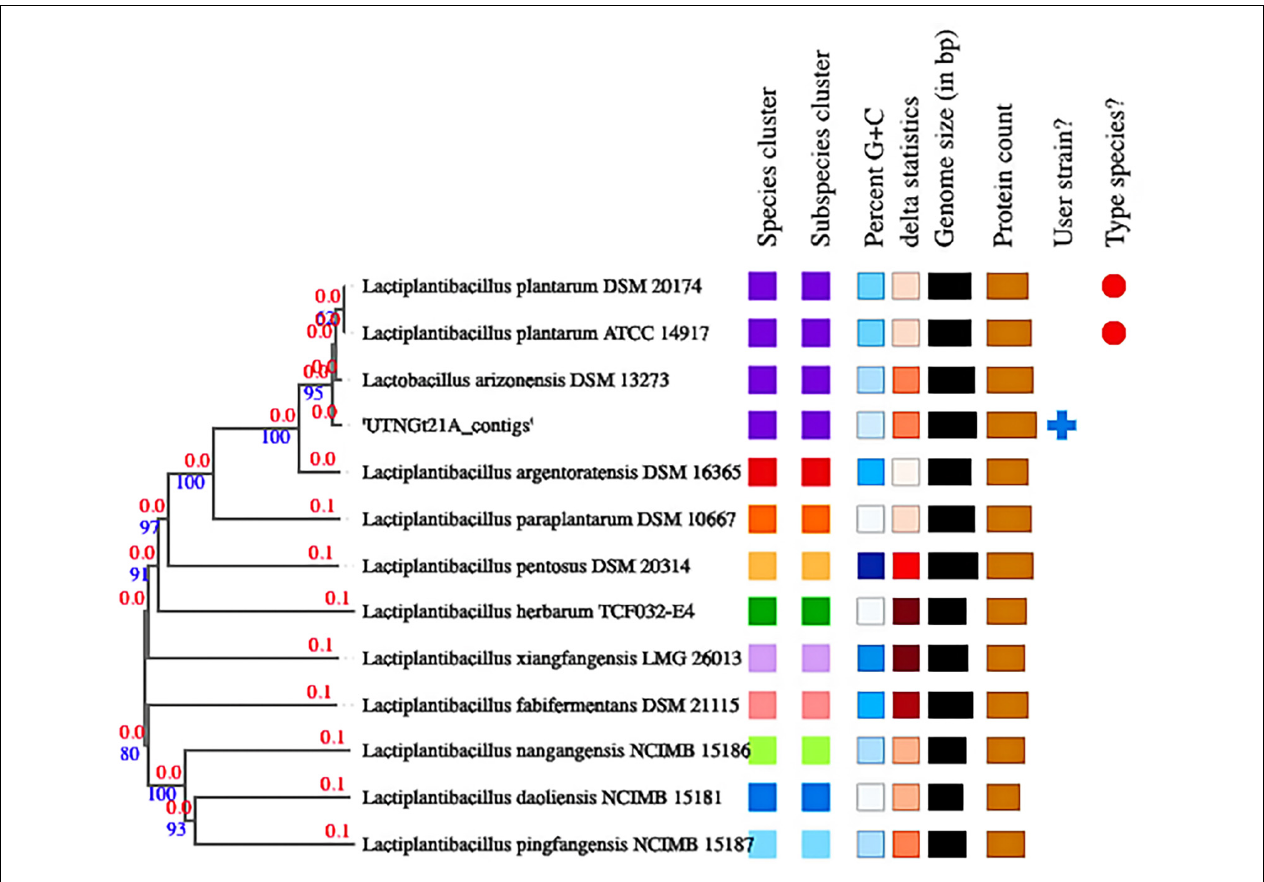
FIGURE 2 | Phylogenetic tree based on TYGS result for the UTNGt21A whole-genome data set. Branch lengths are scaled in terms of GBDP (genome BLAST distance phylogeny method) distance; numbers above branches are GBDP pseudo-bootstrap support values from 100 replications. Leaf labels are annotated by affiliation to (1) species; (2) subspecies clusters; (3) genomic G + C content (min 43.5–46.31); (4) δ values (min 0.077–max 0.185); (5) overall genome sequence length (2.62–3.62 Mbp); and (6) number of proteins